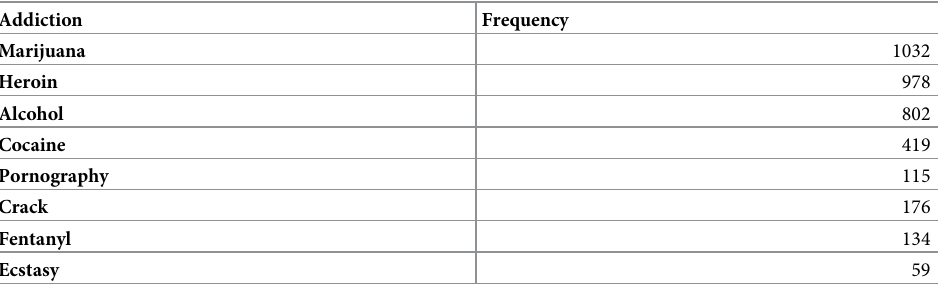
Table 2. Top addiction disclosures on Reddit and frequency of mentions.